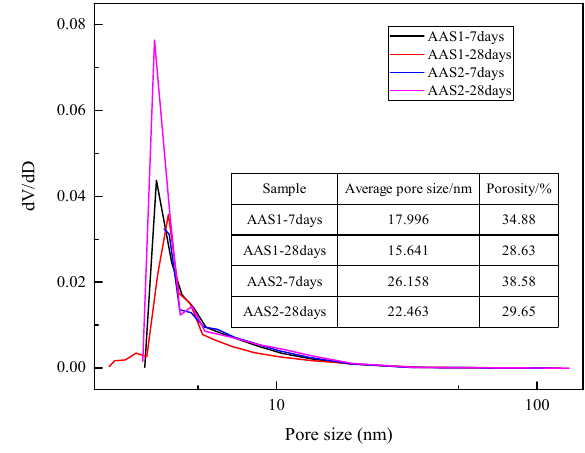
Figure 7. Pore size distribution of AAS.